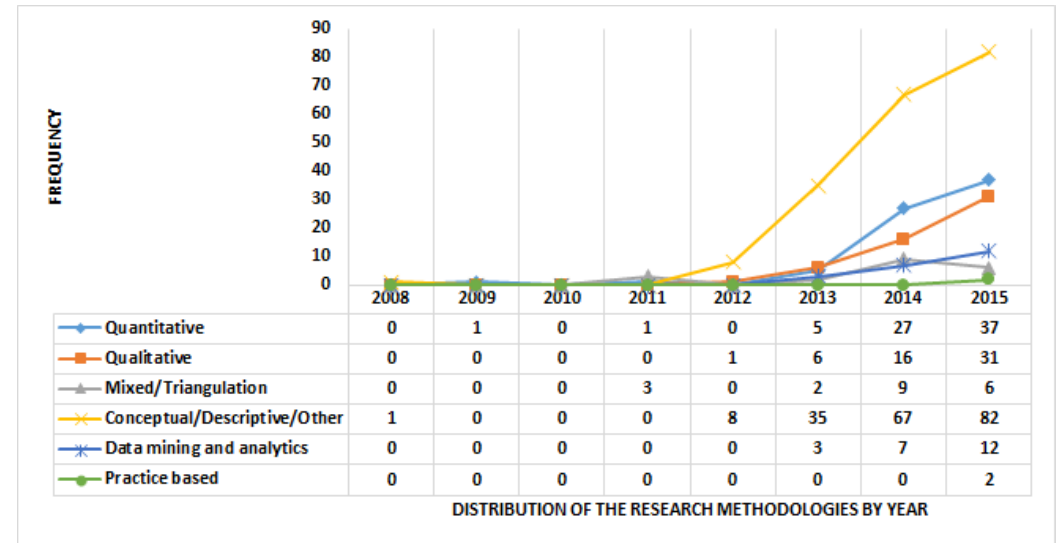
Figure 6. Distribution of research methodologies